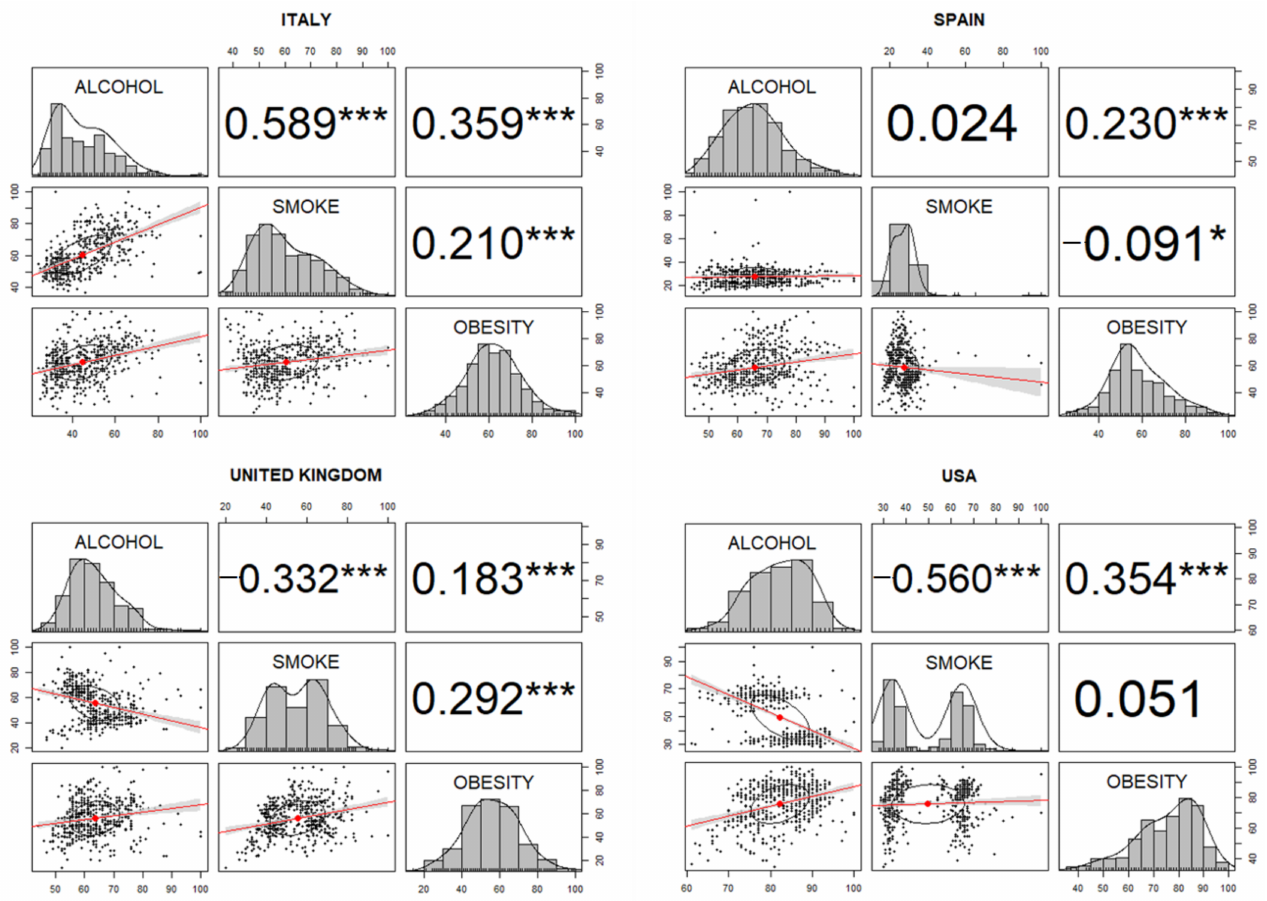
Figure 3. Correlation plots of searches performed by country using country-specific languages. * p < 0.05; *** p <